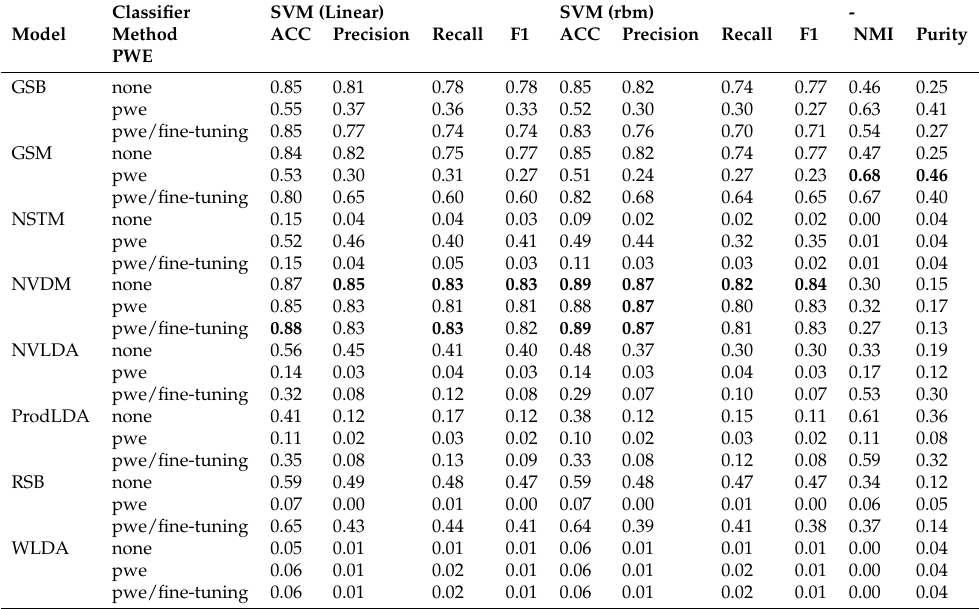
Table 27. Classification and Clustering performance on